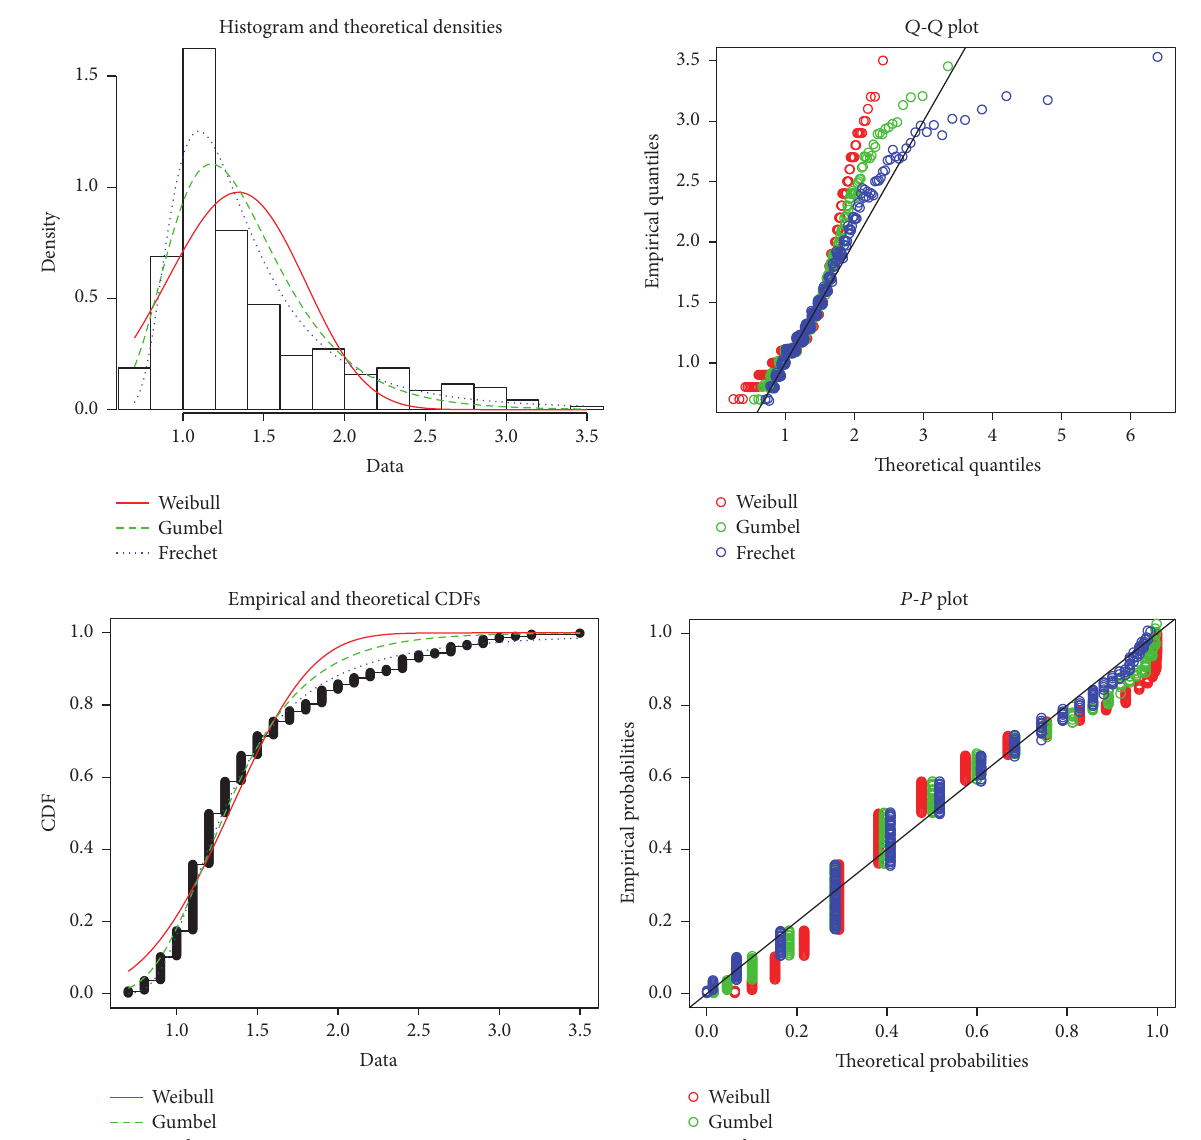
Figure 7: Monthly minimum wind speeds fitted to the GEV class of